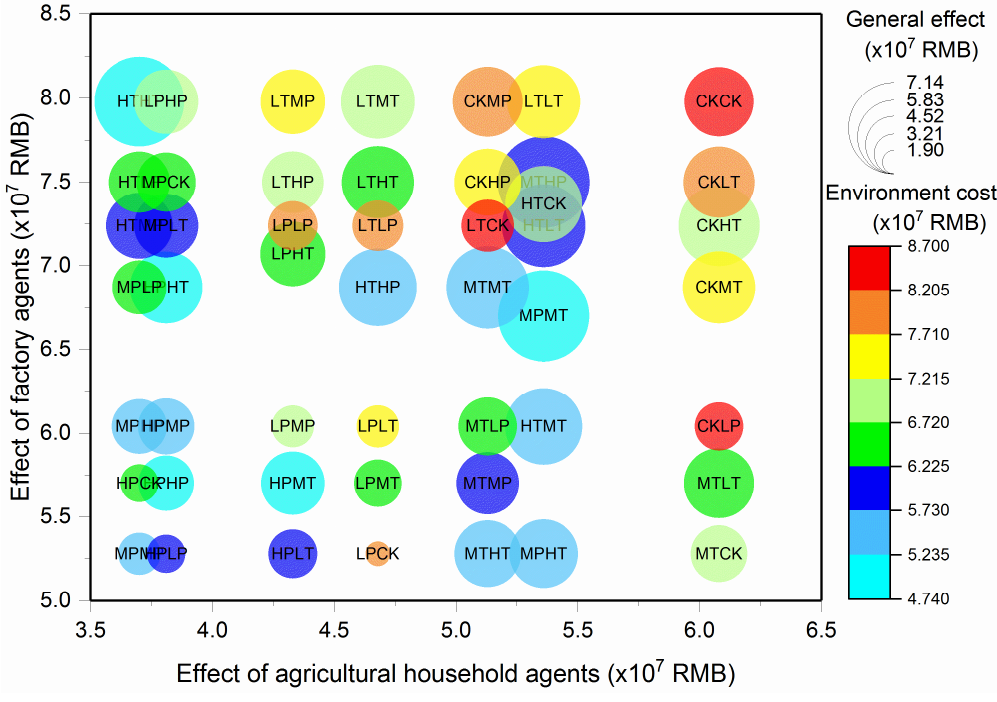
Figure 7. The general effect and agents’ contributions in the system in different scenarios. CK represents the control group; LT, MT, HT represent low tax, medium tax, and high tax, respectively; LP, MP, HP represent low offset, medium offset, and high offset, respectively. The first two letters of the scenarios represent the policy of the agricultural household agents, and the others represent the policy of factory agents. Lighter colors represent lower environmental costs, and larger circles represent larger general effects.